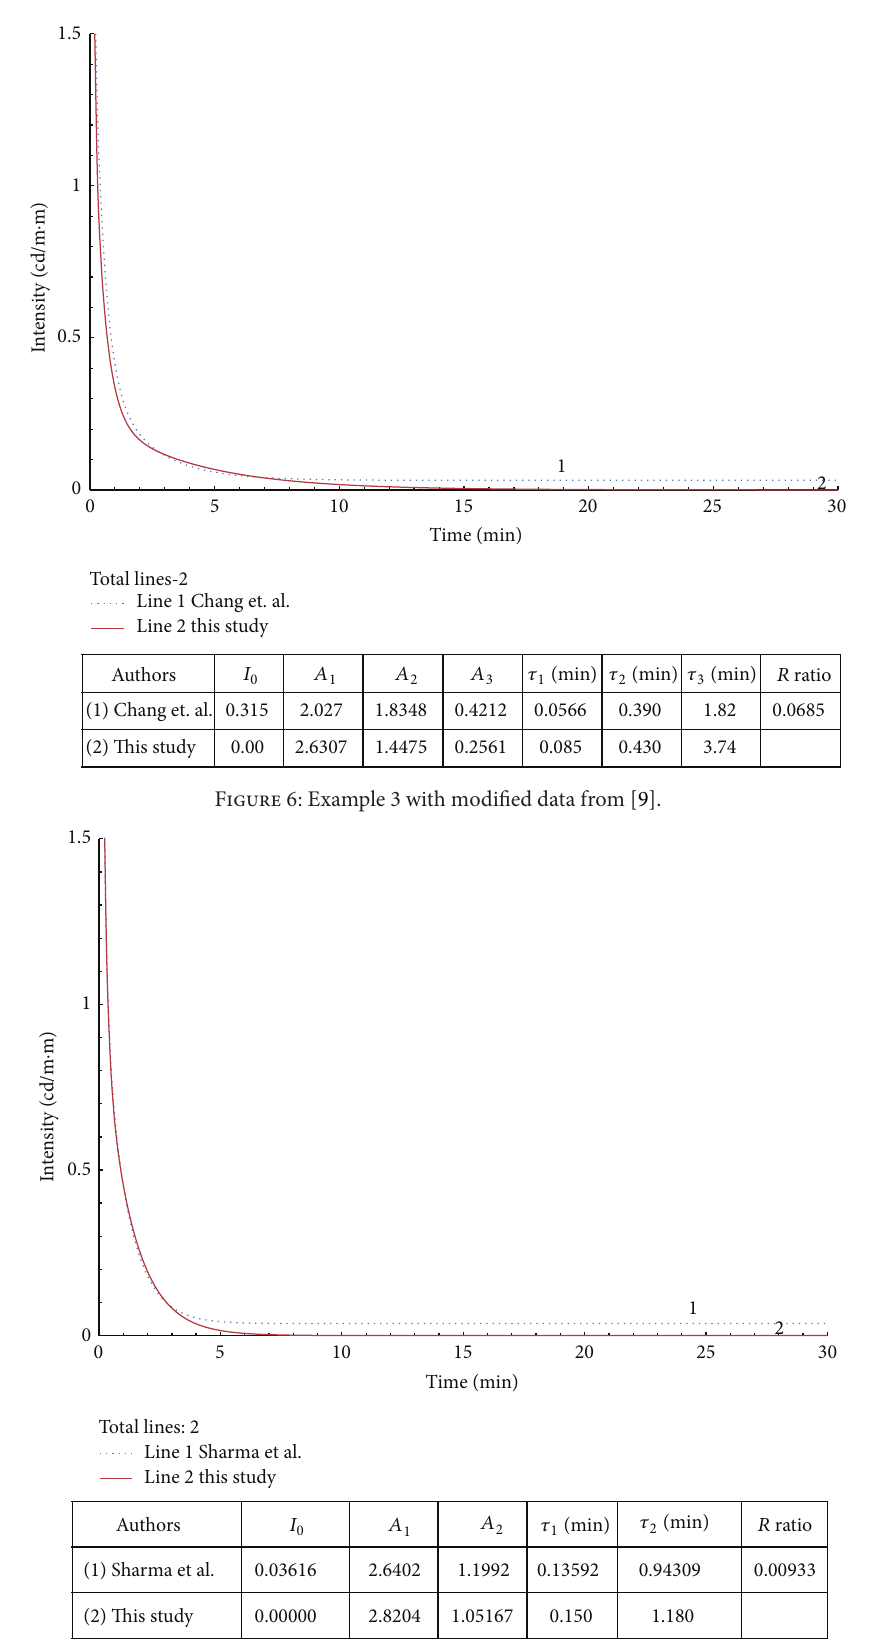
Figure 7: Example 4 with modified data from